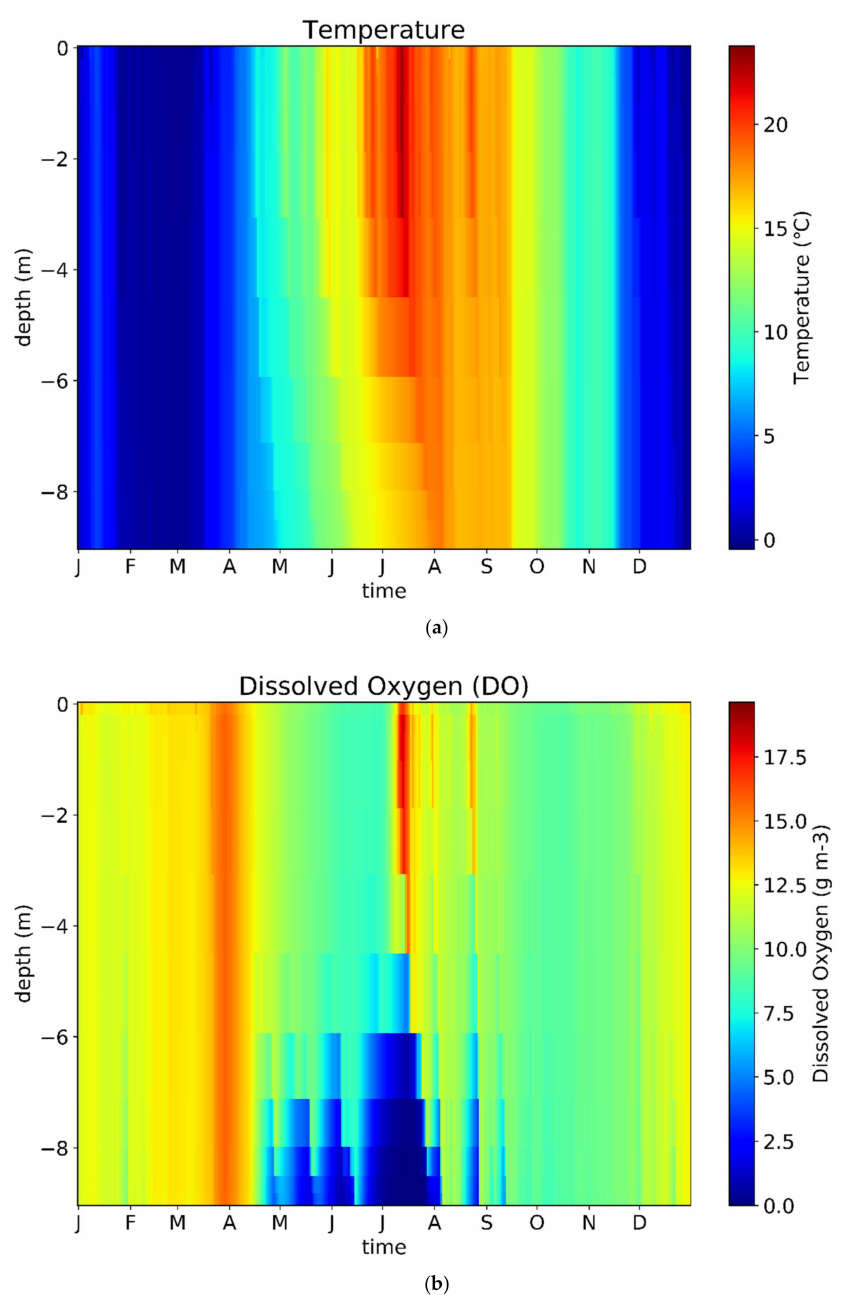
Figure 5. Simulation for the whole water column in 2050 in base scenario. ( a ) Temperature; ( b )